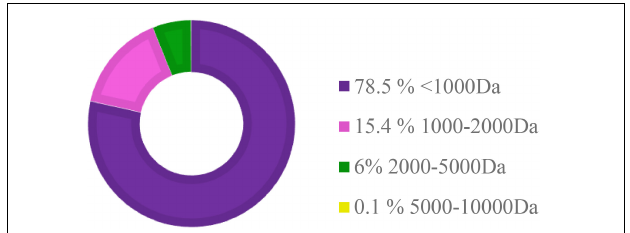
FIGURE 8 | The molecular weight distribution of peptides in hydrolyzed fish protein powder (HFP). Da,